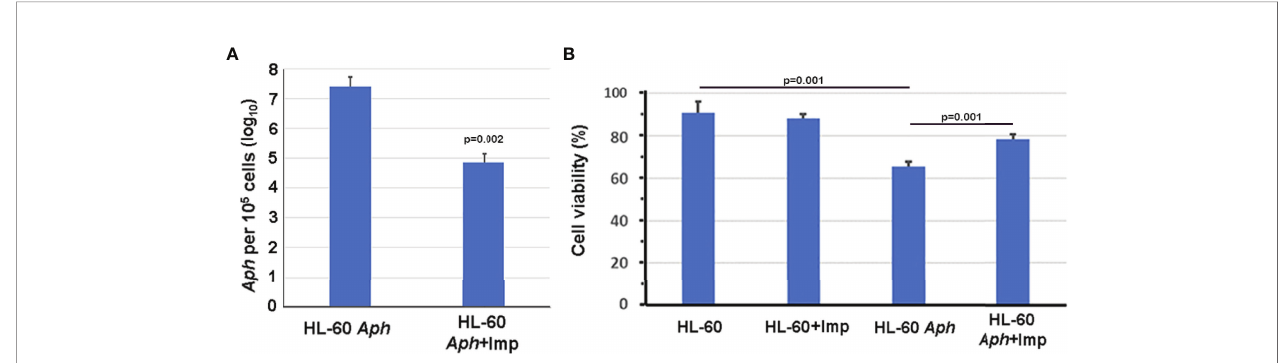
FIGURE 5 | Importazole, an inhibitor of cargo binding to importin- b , inhibits A. phagocytophilum propagation in HL-60 cells (A) without inducing detrimental HL-60 cell viability (B) . Aph , A . phagocytophilum ; Imp, importazole; ANOVA with Tukey post hoc p values <0.05 are shown. Error bars represent s.e.m.